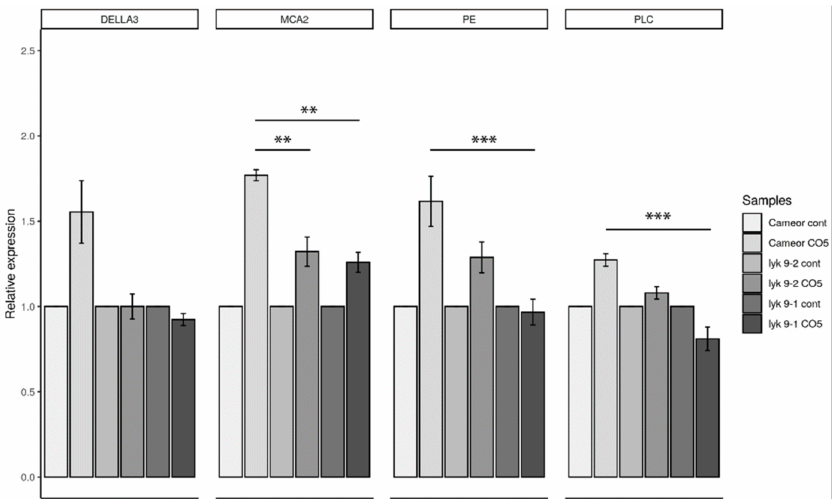
Figure 2. Expression pattern of DELLA3, MCA2, PE and PLC genes in pea roots treated with 10 − 5 M CO5 for 24 h. As a control, medium-treated plants were used. The expression was normalized against the constitutively expressed ubiquitin and actin genes. For each gene, the transcript level in non-inoculated roots of wild-type or mutants was set to 1 (control), and the level in treated roots was calculated relative to the control values. The graphs show the results of three independent experi- ments. The error bars represent standard errors of the mean (SEM) of three repeats. The asterisks indicate statistically significant differences based on one-way analysis of variance (one-way ANOVA), followed by Tukey’s post-hoc test results. (** p < 0.01, *** p < 0.001).